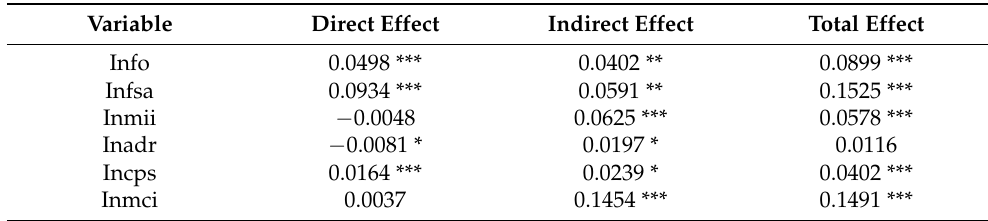
Table 16. Decomposition results of the spatial effect of the total agricultural output value on agricul- tural green development under the economic